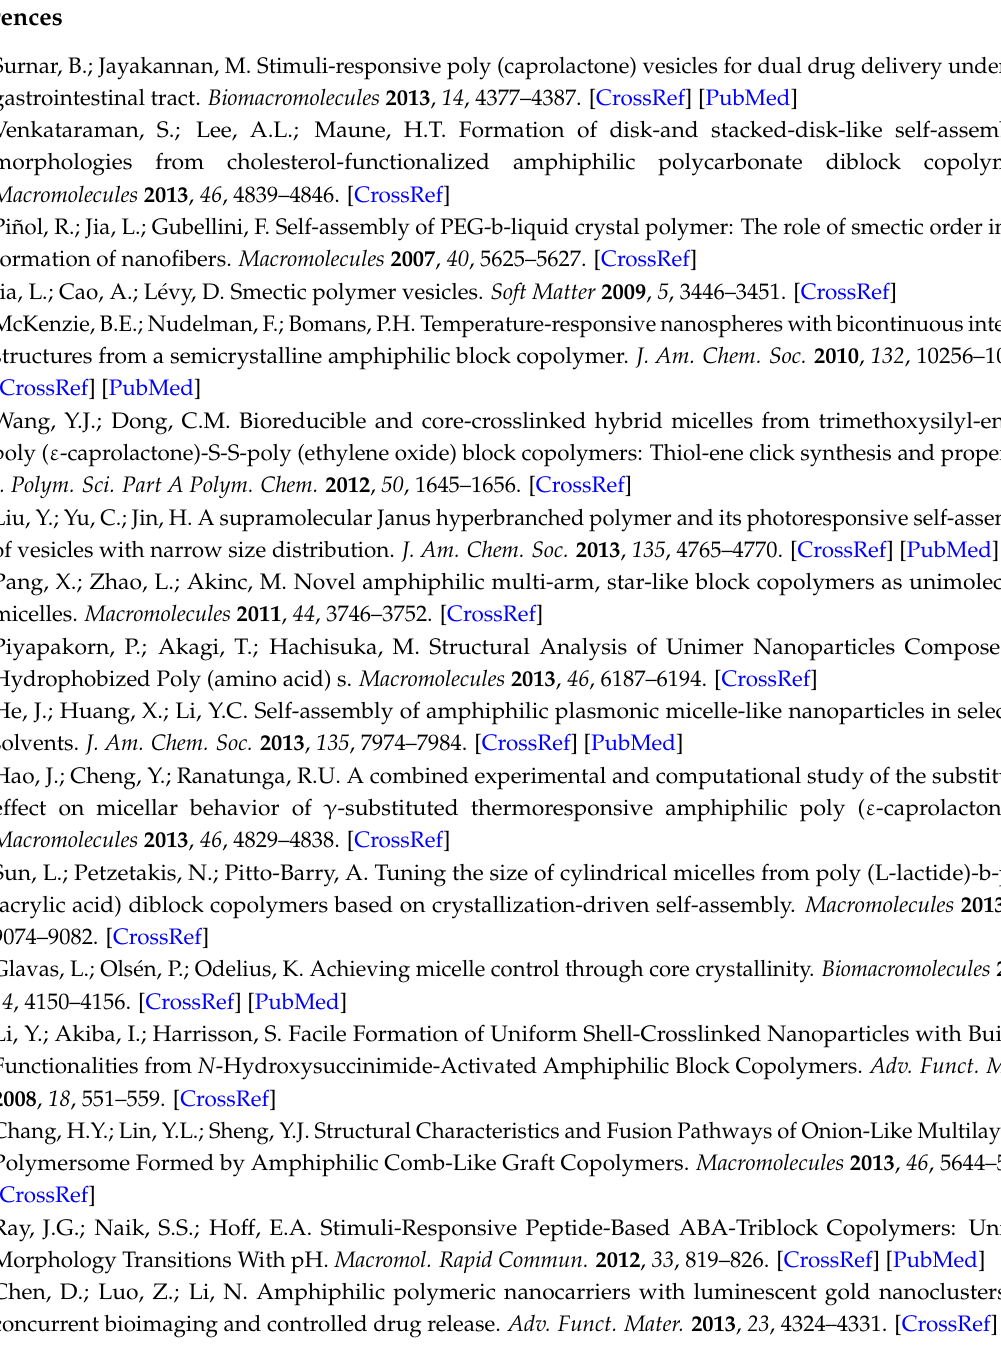
Figure S5: 1 H NMR spectra of mPEG 43 - b -PMCC 40 , Figure S6: TEM images of mPEG 43 -PMCC 25 -P(MCC-DHO) 15 self-assembly obtained in water at (A) pH = 6 and (B) pH =